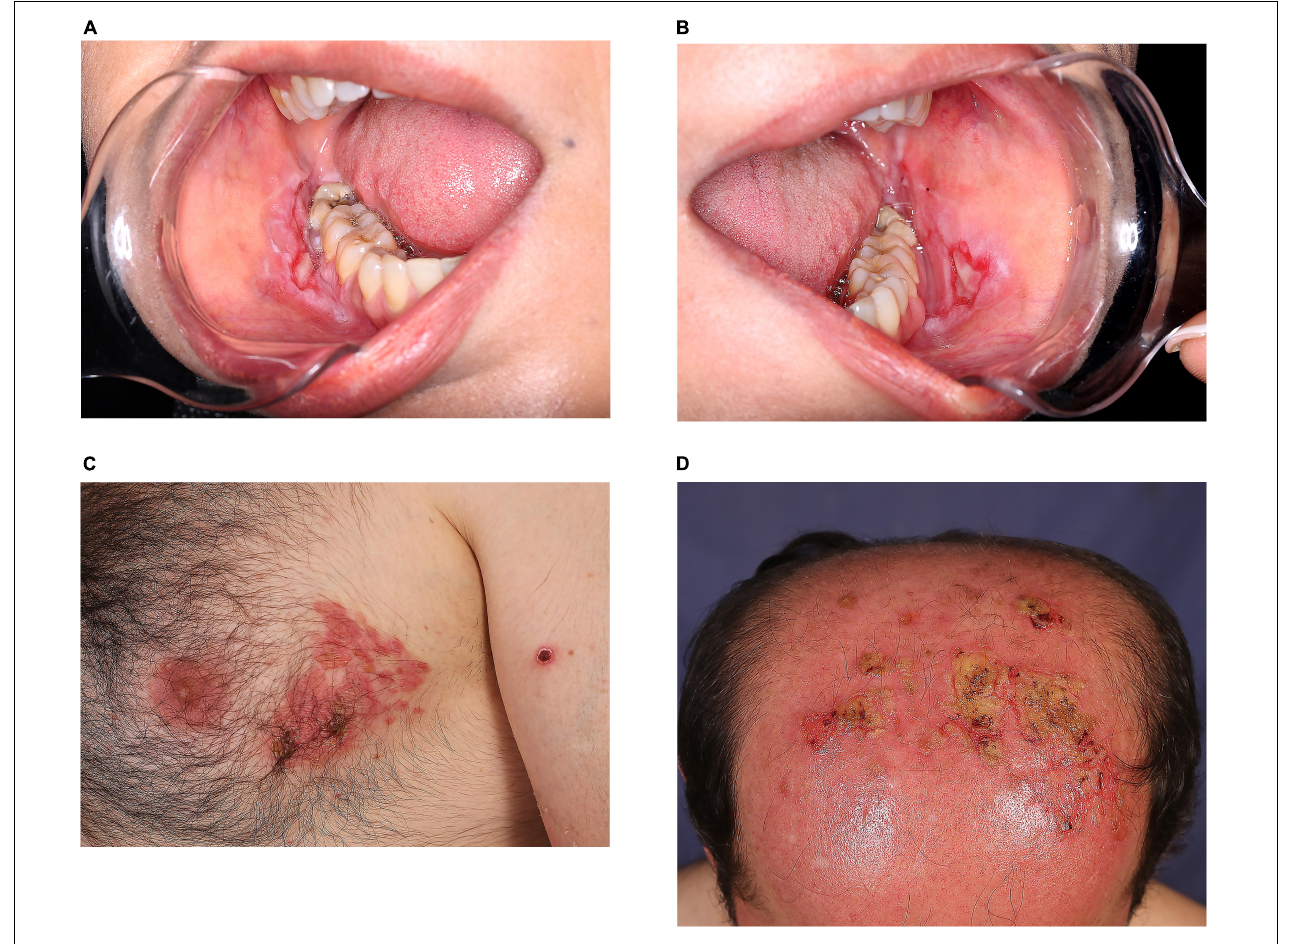
FIGURE 2 | Clinical appearance of pemphigus vulgaris exacerbation in two patients vaccinated against SARS-CoV-2: a 39-year-old woman who experienced disease exacerbation 17 days after the first dose of Sinopharm vaccine (A,B) ; a 46-year-old man who experienced disease exacerbation 7 days after the second dose of COVIran Barekat vaccine (C,D)